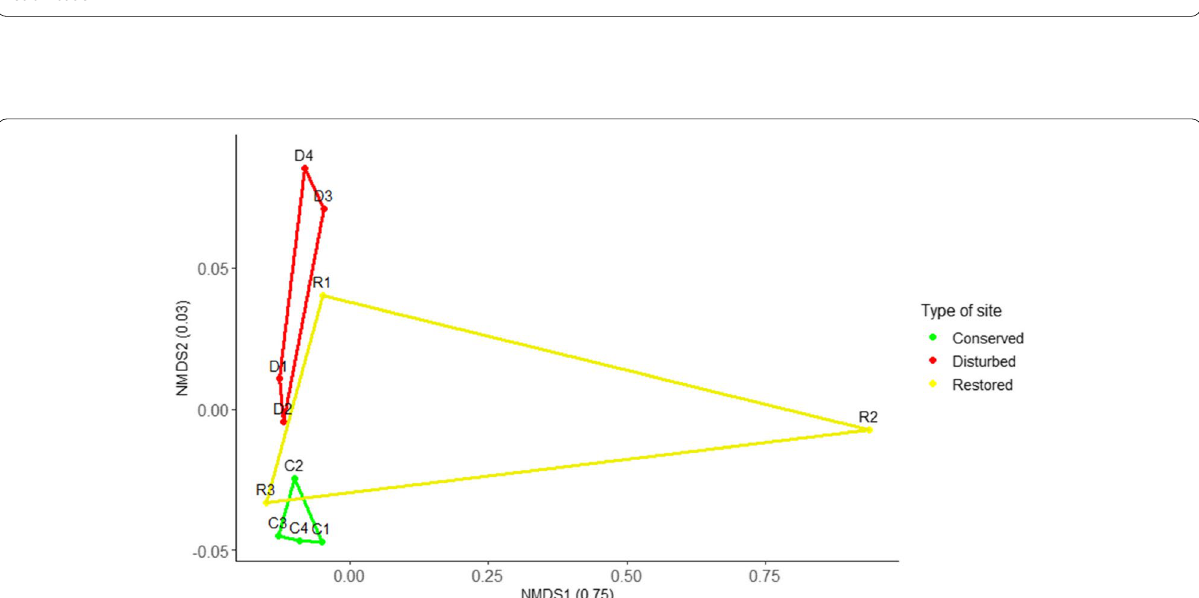
Fig. 7 Non‑metric Multidimensional Scaling showing the ordination of the 11 study sites in the PSAER, based on trophic guilds. Dots represent conserved sites; triangles represent disturbed sites and squares represent restored sites. The lines are the convex hulls of the polygons formed in each case